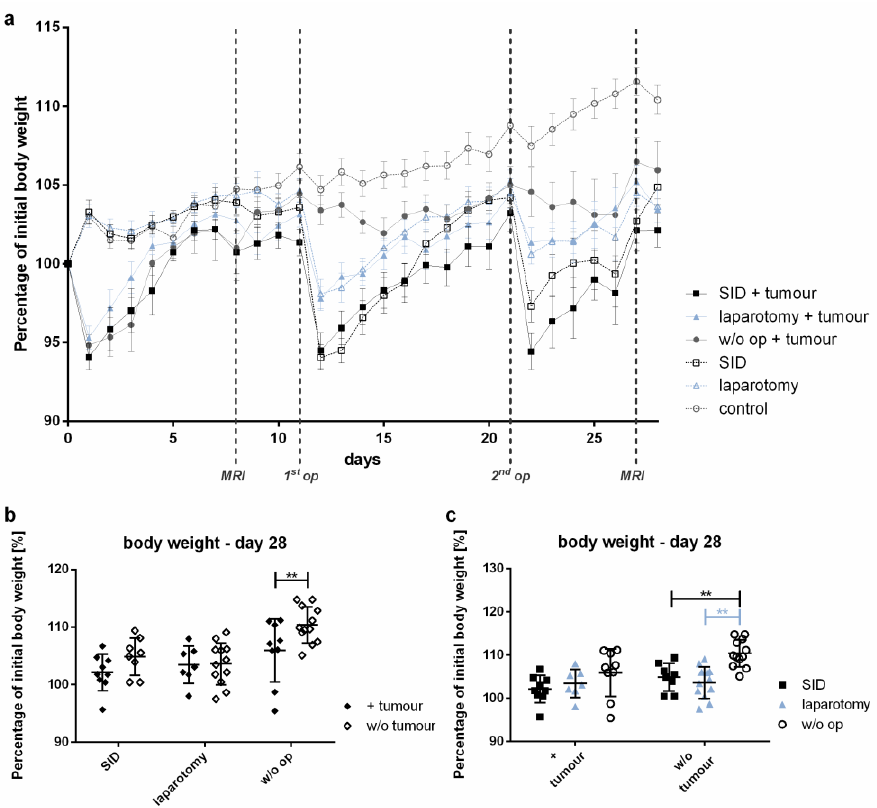
Figure 3. Body weight development. The body weight was determined daily. The body weight is shown as the percentage of the pre-interventional body weight (day 0). ( a ) The graph illustrates the body weight development during the experiment. ( b ) Comparison of the mean body weight at the end of the experiment (day 28) of the tumour vs. w/o tumour in SID, laparotomy or in w/o operation; ( c ) comparison of the mean body weight on day 28 of the SID vs. laparotomy vs. w/o operation in tumour-bearing mice and in tumour-free mice. ( a ) Values represent the mean and error of the mean; n = 15 animals per group; ( b , c ) values represent the mean and standard error, n = 9–11 (SID + tumour: n = 9; laparotomy + tumour: 7; w/o op + tumour: 9; SID: 8; laparotomy/control: 11); ** p <